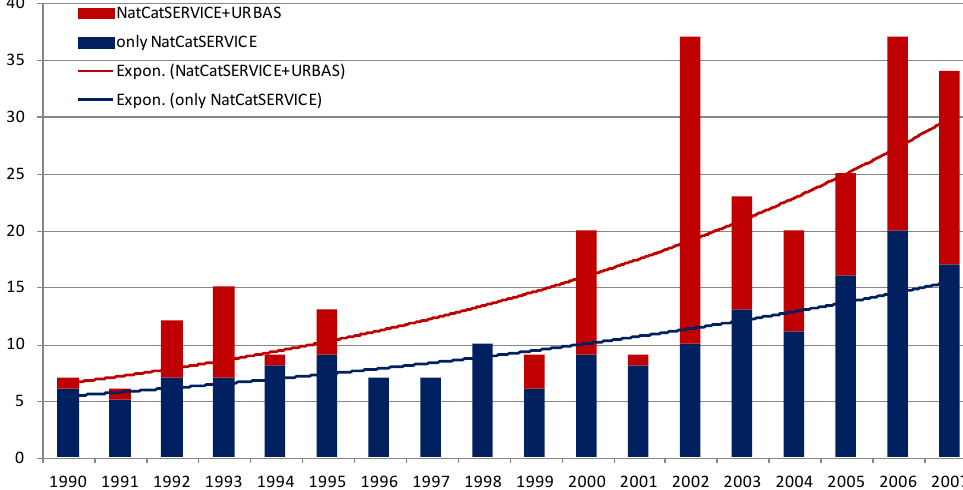
Fig. 5. Number of river floods, flash floods and wet convective events in Germany from 1980–2010 with trends. Figure 5. Number of river floods, flash floods, and wet convective events in Germany from 1980–2010 with trends.